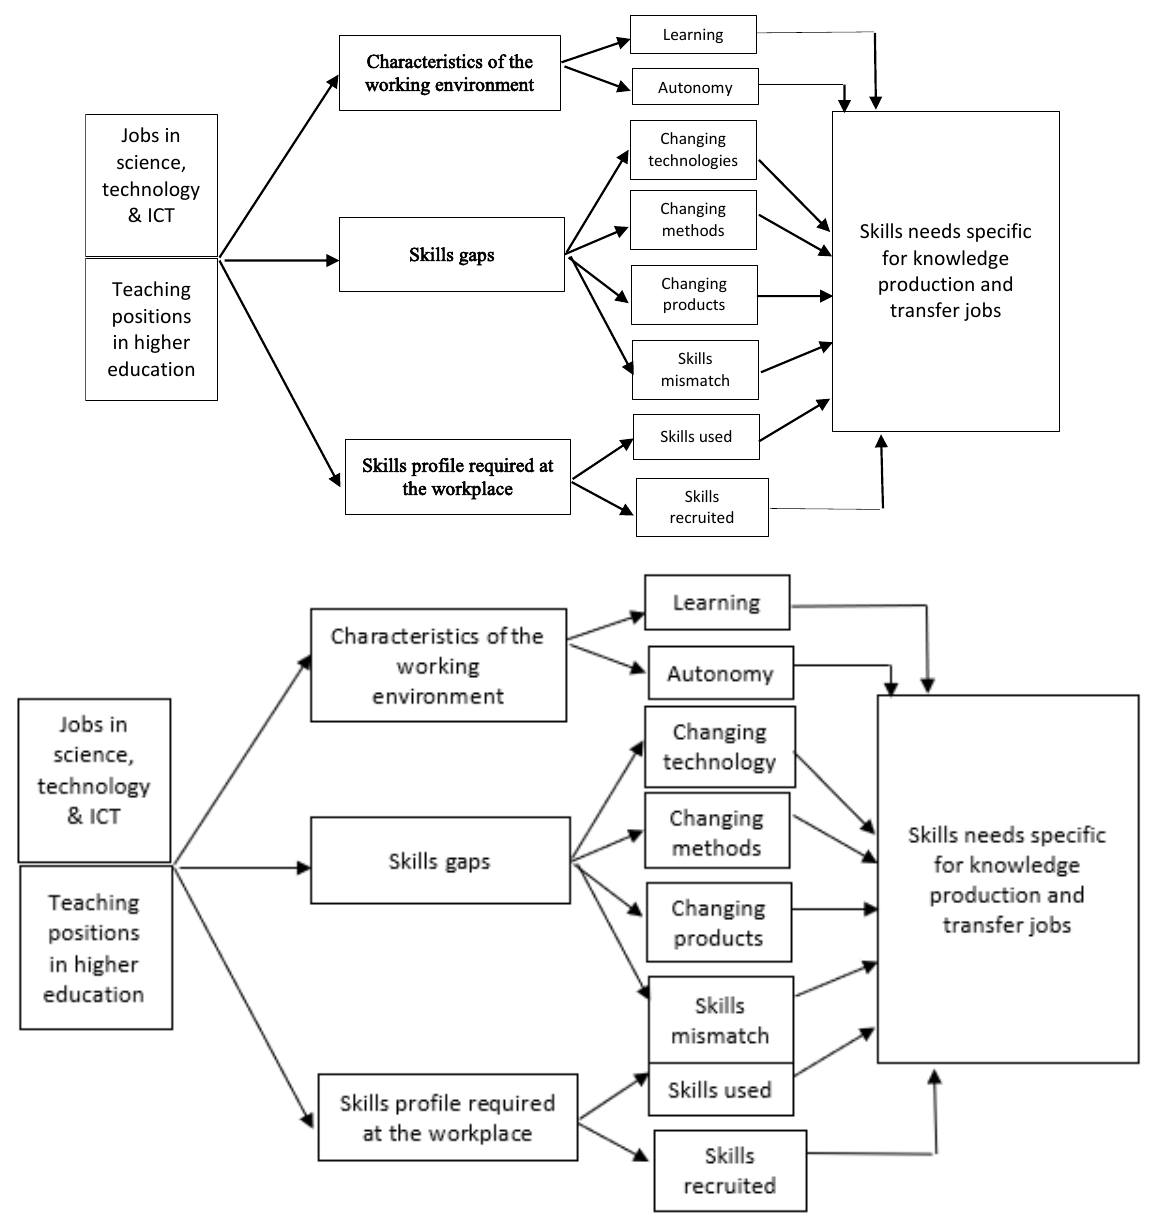
Figure 1. Conceptual model of the research study.